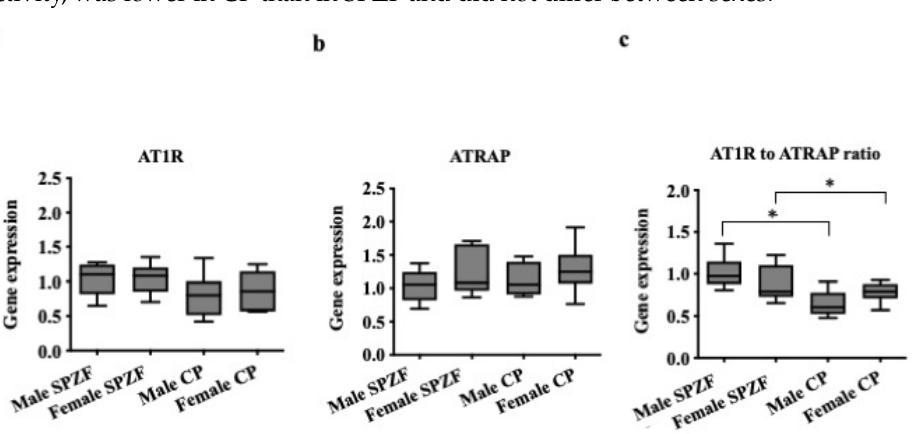
The mRNA levels of AT1R and ATRAP in the renal arterial PVAT did not differ among the groups (Figure 4a,b). However, the AT1R/ATRAP ratio (Figure 4c), as an index of AT1R activity, was lower in CP than in SPZF and did not differ between sexes.